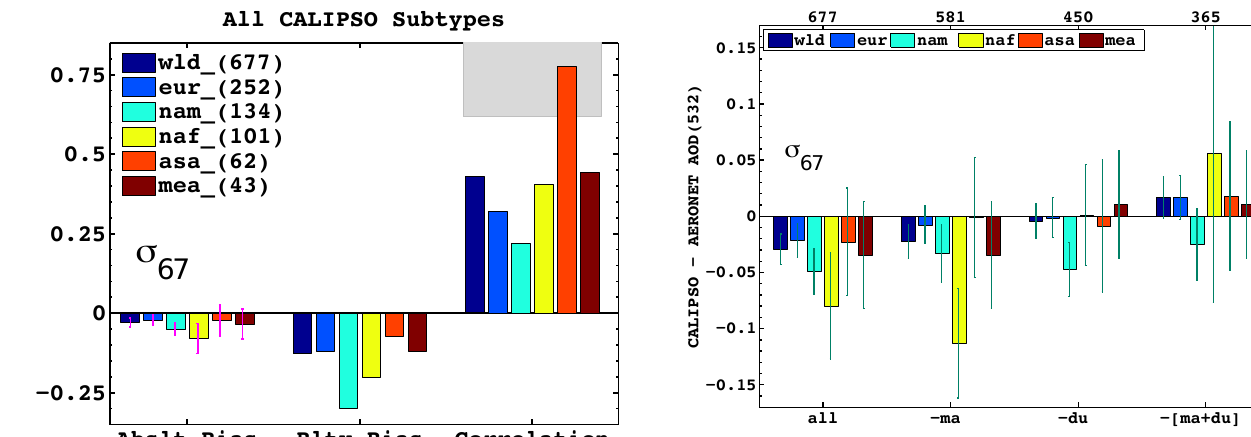
Fig. 7. Absolute bias for all CALIPSO aerosol subtypes (all), all subtypes except marine (–ma), all subtypes except dust (–du), and all subtypes except marine and dust (–[ma+du]). The color of the bars correspond to the five regions in Figure 5 with the largest sam- ple sizes and all eight regions (wld). Numbers along the top axis indicate the total number of synchronized overpasses for all eight regions (wld).